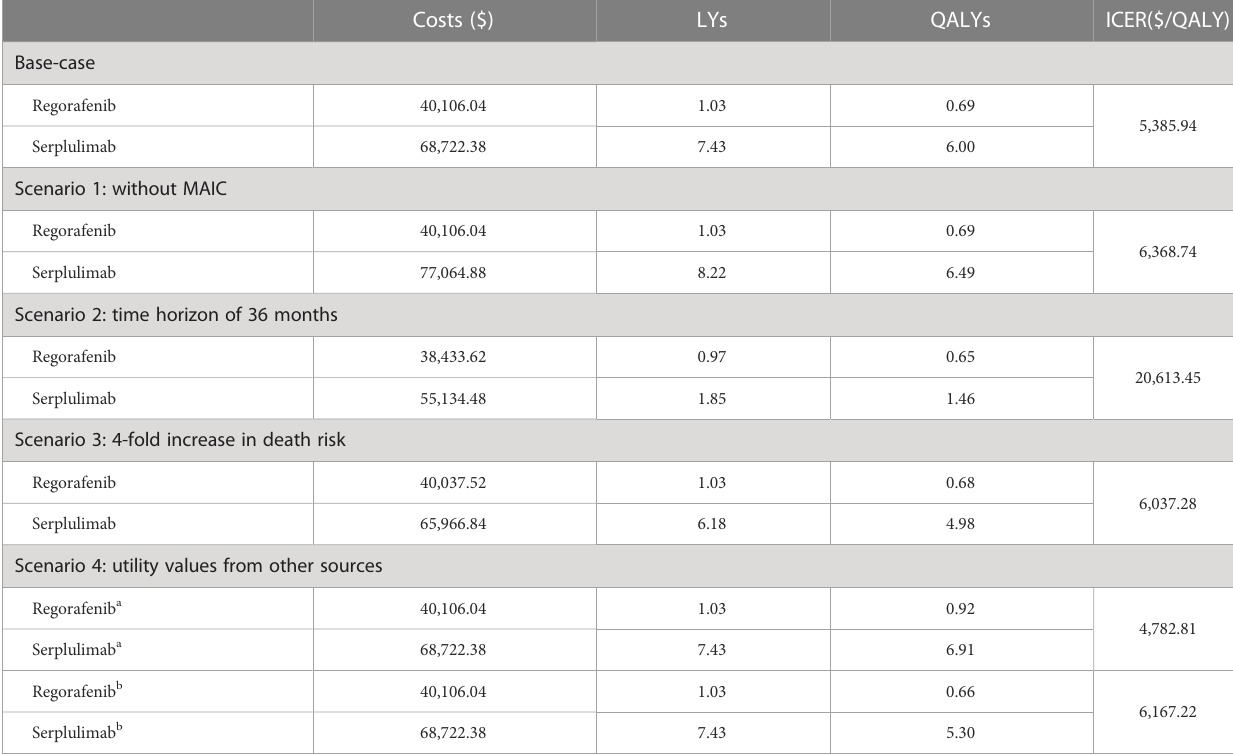
TABLE 2 Cost effectiveness results.